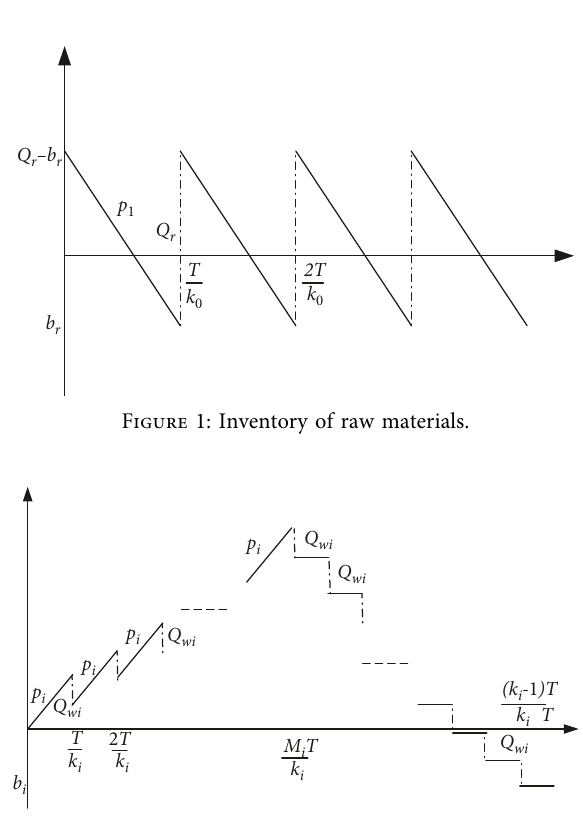
Figure 2: Inventory of manufacturer’s